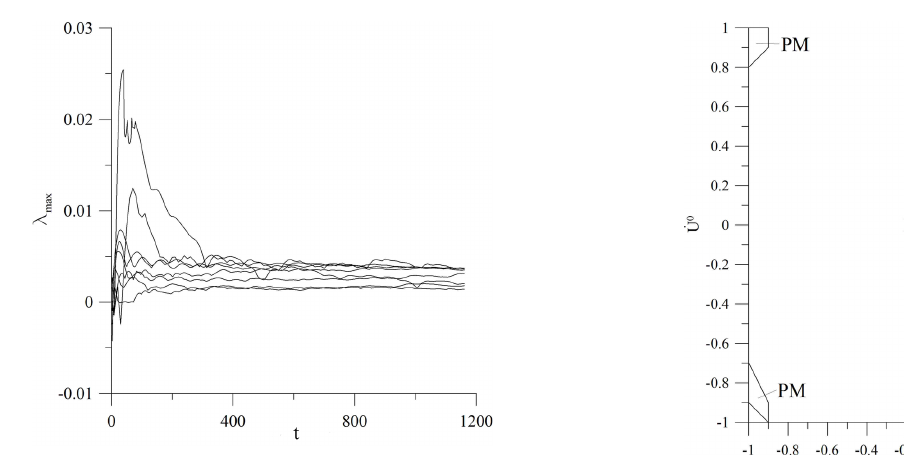
= ˙ U 0 = ˙ U 0 , U 0 = 1 2 1